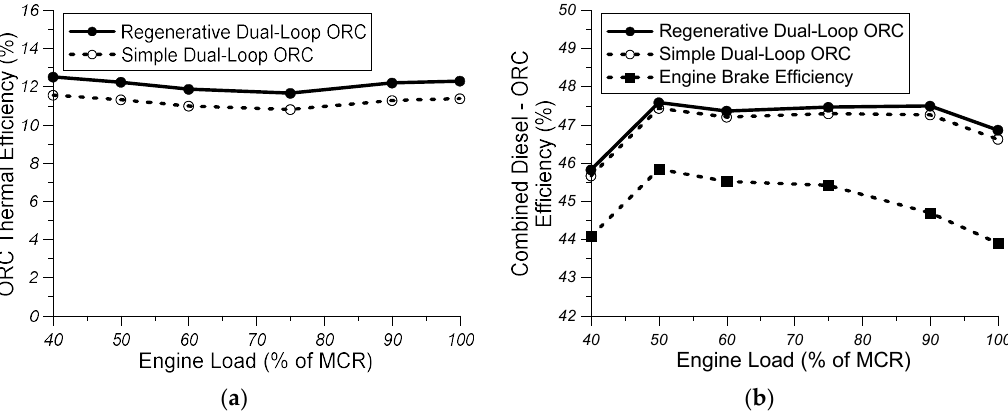
Figure 20. Comparison of ( a ) Rankine cycle efficiency and ( b ) overall efficiency of the combined diesel engine–ORC system between the simple dual-loop ORC and the regenerative dual-loop ORC.